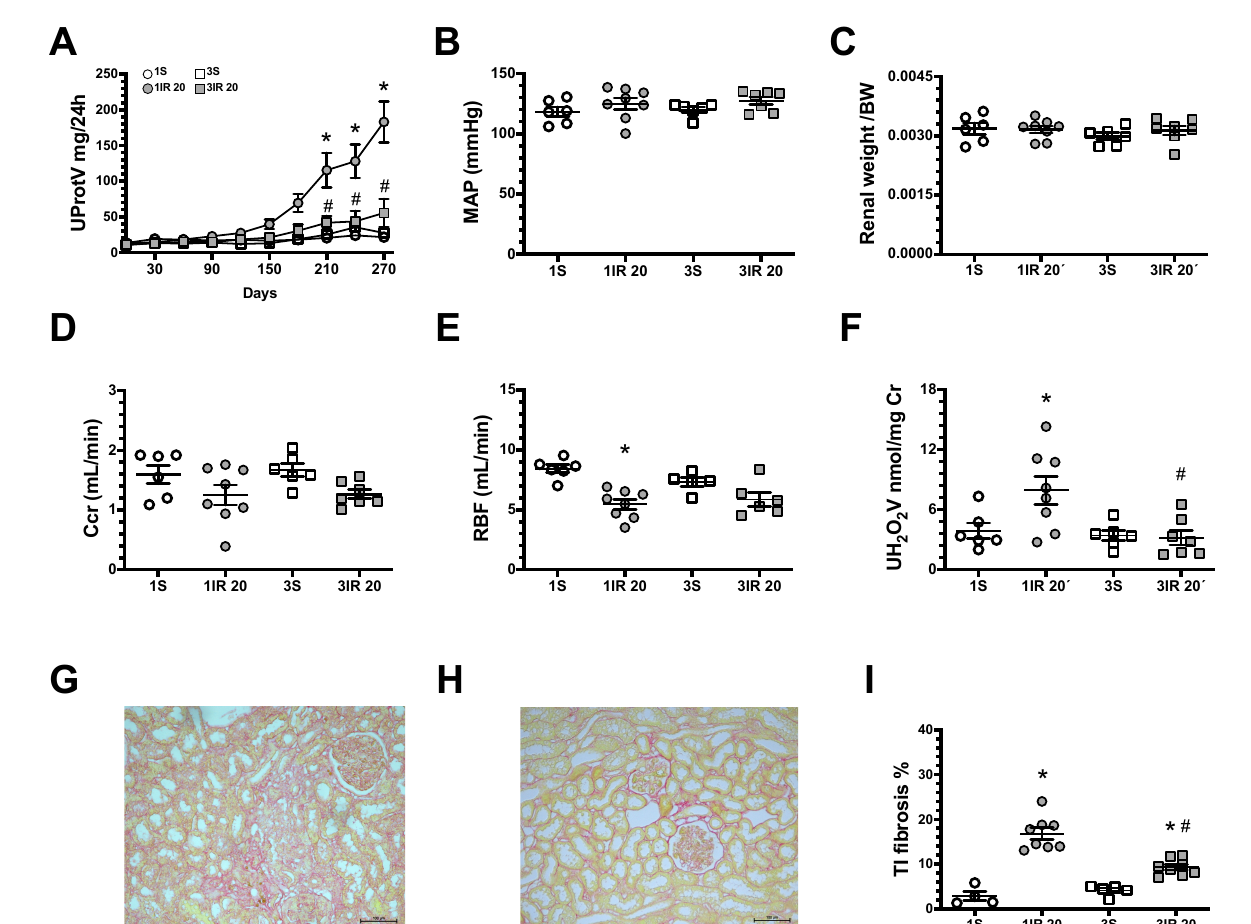
Figure 2. Repeated episodes of mild ischemic injury prevent the progression to CKD. ( A ) Urinary protein excretion measured every 30 days during nine months of the follow-up. At the end, the rats were studied: ( B ) mean arterial pressure (MAP), ( C ) renal weight/body weight ratio, ( D ) clearance of creatinine (Ccr), ( E ) renal blood flow (RBF), and ( F ) urinary H 2 O 2 excretion. Representative microphotographs of Sirus red stained slices from a kidney rat underwent ( G ) one IR episode or ( H ) three IR episodes (magnification 150 × ), and in ( I ) tubule-interstitial fibrosis percentage. The sham group underwent one surgery (1S) is represented in white circles, rats underwent one IR episode for 20 min (1IR) in gray circles, sham group subjected to three false surgeries, one each 10 days (3S) is in white squares, and three episodes of 20 min, one each 10 days (3IR) is in gray squares. * p < 0.05 vs. both 1S or 3S; # p < 0.05 vs. 1IR